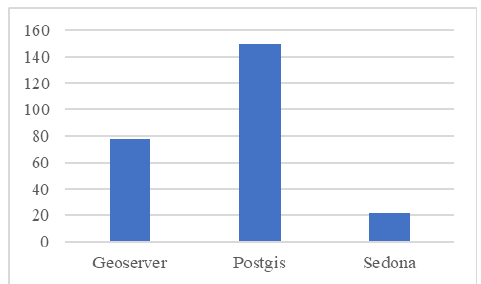
Figure 7. Total Execution Time of different construction modes (in